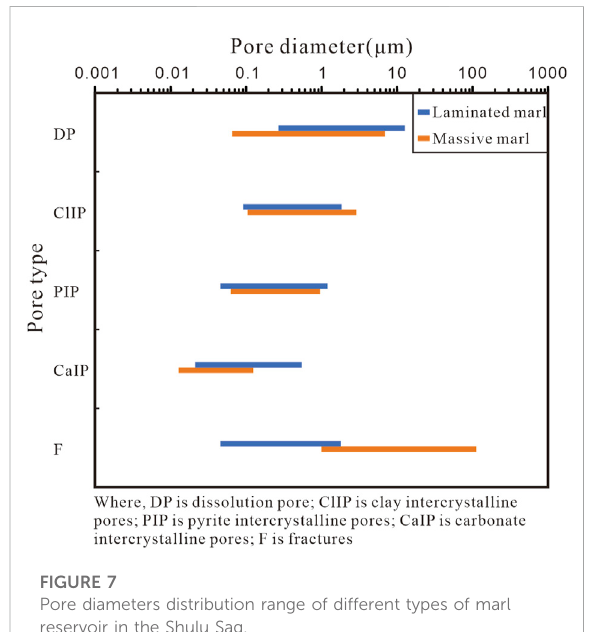
FIGURE 7 Pore diameters distribution range of different types of marl reservoir in the Shulu